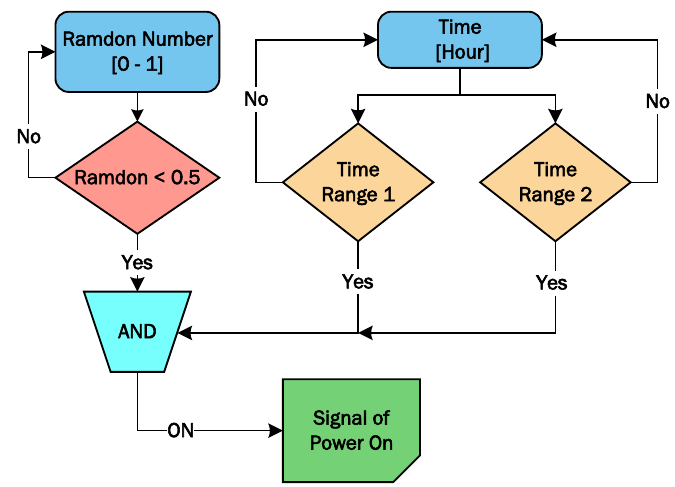
Figure 8. Modeling time ranges of use.